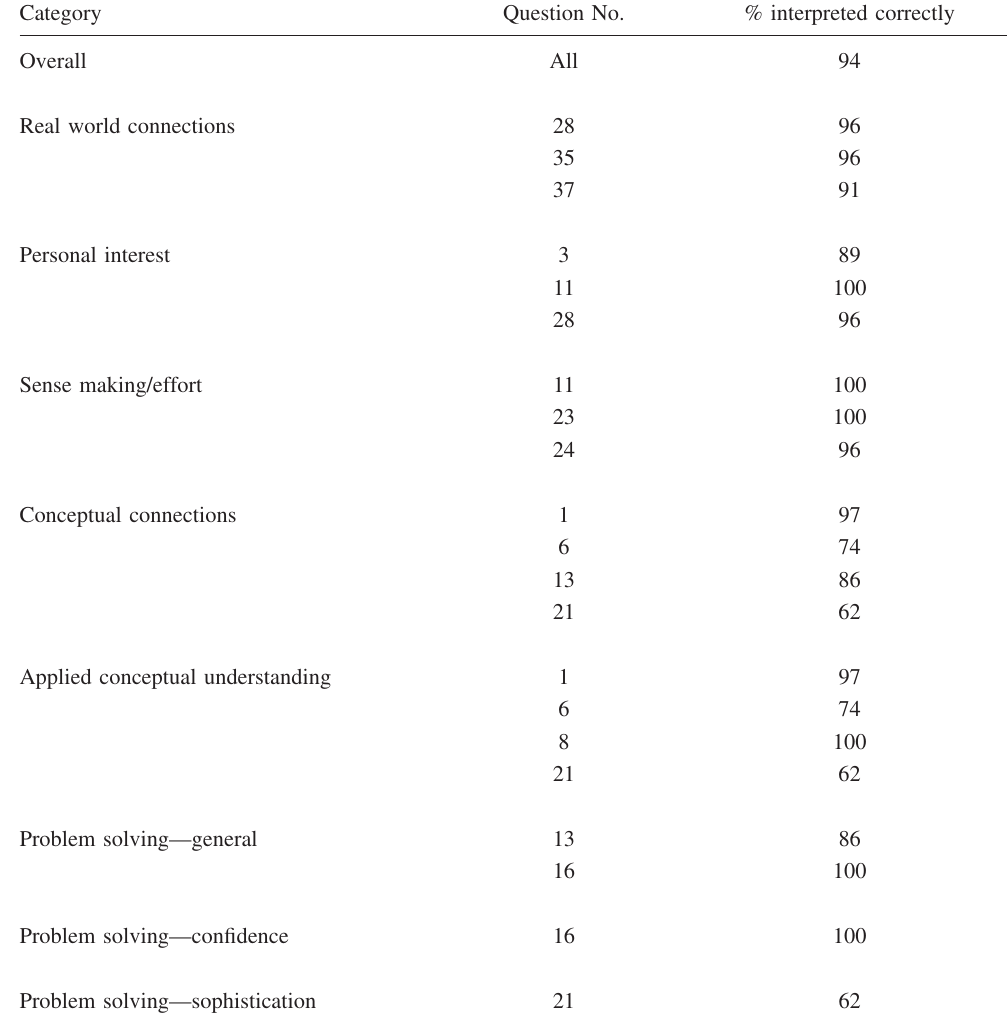
TABLE I. Percentage of students whose interpretation of the CLASS item agreed with that of the authors, listed by